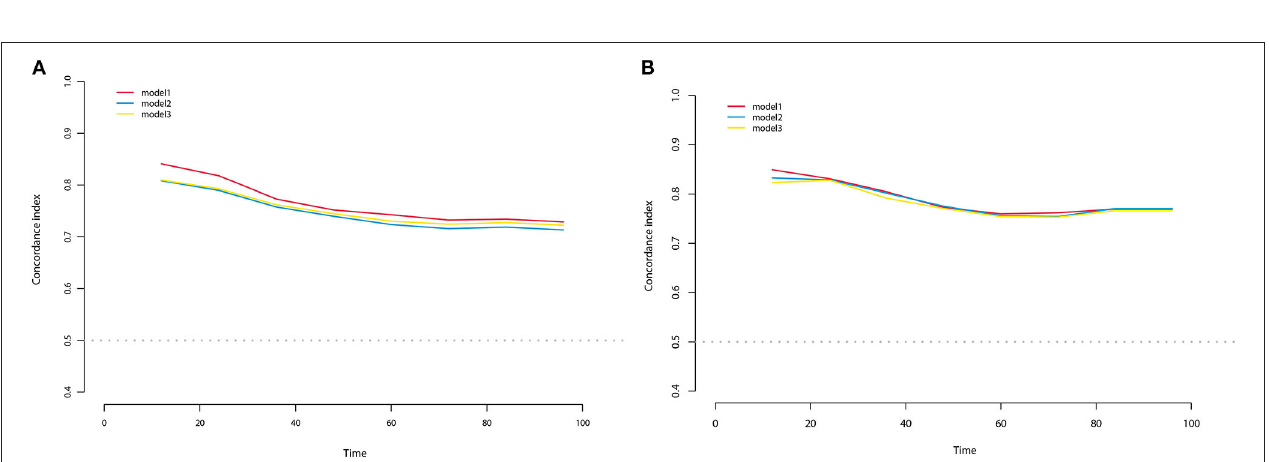
FIGURE 1 | Nomogram predicting the 3-, 5-, and 10-years (A) OS and (B) CSS of patients with primary urachal carcinoma by summing the points identified on the points scale for each variable. The total points projected on the bottom scales determine the probability of survival.